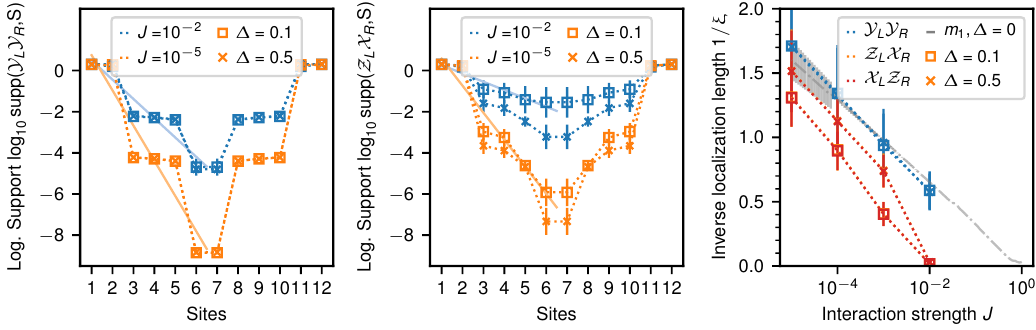
Y Figure 2: (Left, center) Logarithmic support log supp ( B , S ) of the edge modes Y L R 10 X and Z for η = 1 on N = 12 sites, where S is the left and right part of the L R system where blocks of even size centred around the middle of the chain have been removed. Colour encodes the used interaction strength J and markers encode the disorder strength ∆ . Each data point is an average over 100 realizations with error bars indicating the standard deviation of the data. Dotted lines are a guide to the eye. Solid lines show linear fits of the data for ∆ = 0.1, which allow to extract the localization length ξ . Right: Interaction dependence of the localization length ξ for all three edge modes. Here, color encodes the three modes and markers again encode X X disorder strength ∆ . The data for Z and Z overlaps completely which is why L R R L it is hard to spot the orange markers indicated in the legend. Again, the errorbars show the least-squares errors of the fit. The grey line is taken from the non-interacting results as a